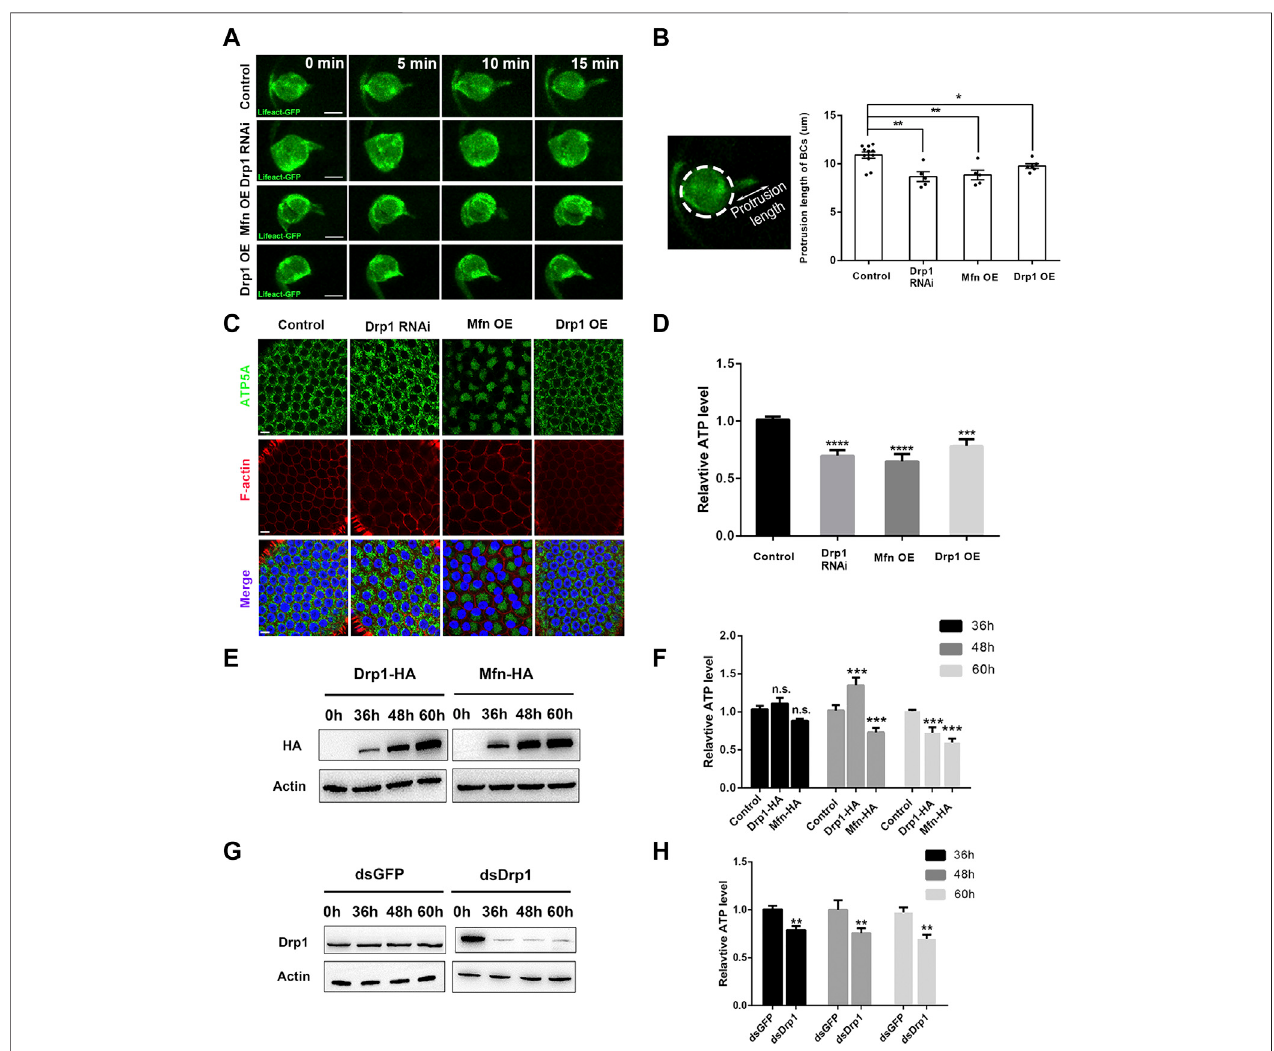
FIGURE2| Drp1-mediated fi ssionpromotesleadingprotrusionthroughitsregulationofATPlevels. (A) Liveimagingofmigratorywildtype, Drp1RNAi , MfnOE ,and Drp1OE bordercellsthatalsoexpress UAS-Lifeact-GFP ,whichlabelsF-actinandoutlinestheleadingprotrusion.See SupplementaryVideosS1 – 4 fordetails. (B) The protrusionlengthismeasured asthedistancebetweenthetipoftheprotrusiontotheperipheryofthecluster. Drp1RNAi , MfnOE ,and Drp1OE bordercellclustershave signi fi cantlyshorterleadingprotrusionscompared withthewildtypecontrol.Eachdatapointrepresentsthelengthofthelongestleadingprotrusion measuredfrom eachliveimagingvideo, “ n ” isthenumberofvideosexaminedforeachgenotype.Az-seriesof9-10confocalsectionsweretakeneveryminute.Aftergoingthroughallthe z-series, theconfocal section with thelongest protrusion visible wasselected and measured. (C) Images offollicle cells stainedwithATP5A (for mitochondria), phalloidin (forF-actin)andDAPI(fornuclei)withindicatedgenotypes. (D) Ovariesthatexpress Drp1RNAi , MfnOE ,and Drp1OE by Gr1-Gal4 havelowerATPlevelscomparedwith thecontrol( Gr1-Gal4 and UAS-lacZ ).TherelativeATPlevelswerenormalized againstthecontrol(seeMethods). (E,F) S2cellstransfectedwith Drp1-HA and Mfn-HA for 36,48and60 hrespectively.TheirexpressionlevelswereanalyzedbyWesternblot (E) ,andtheirATPlevelsweredeterminedbyATPassaykits[ (F) ,seeMethods]. (G,H) S2cellstransfectedwith dsGFP or dsDrp1 for36,48and60 hrespectively.Theirexpressionlevelswereanalyzed byWestern blot (G) .TheATPlevelsof dsDrp1 treated cells were signi fi cantly decreased from 36 to 60 h, as compare with the dsGFP control. Scale bars: 10 μ m. Error bars indicate SD * p < 0.05, ** p < 0.01, *** p < 0.001, **** p <